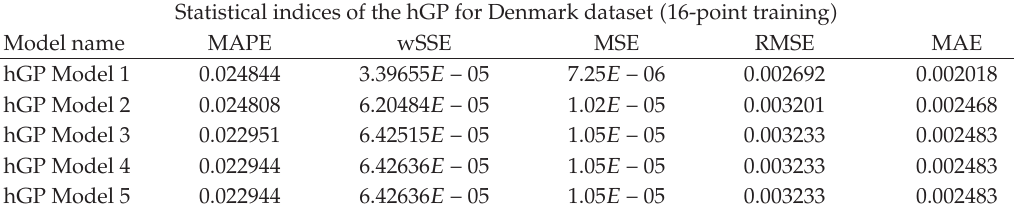
Table 19: Statistical indices of the first five produced hGP models for Denmark (cid:2) forecast period—2 years (cid:3) .